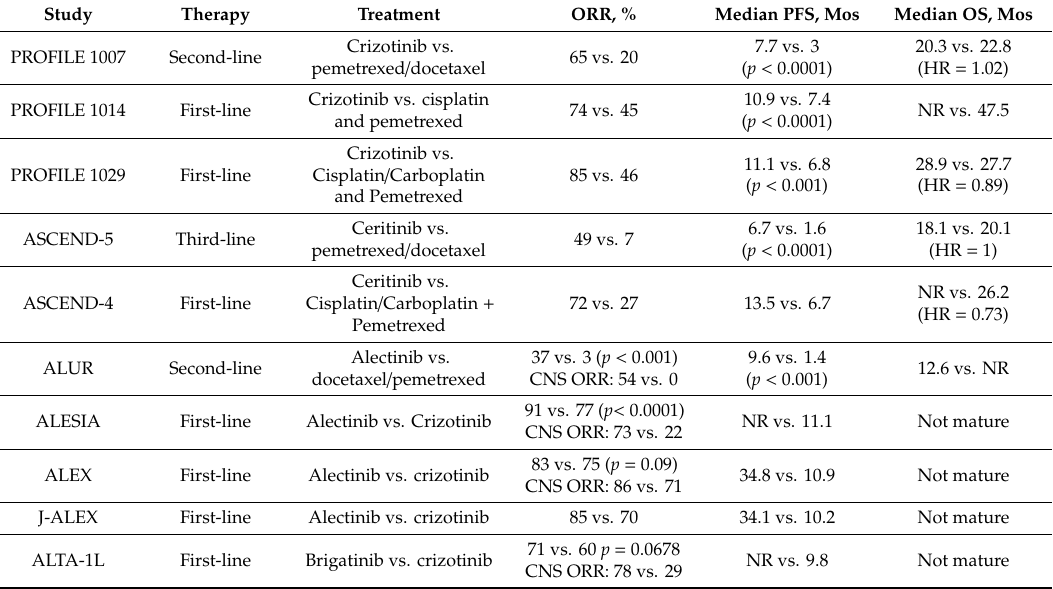
Table 5. Phase 3 comparative studies in the targeted therapy of ALK-rearranged